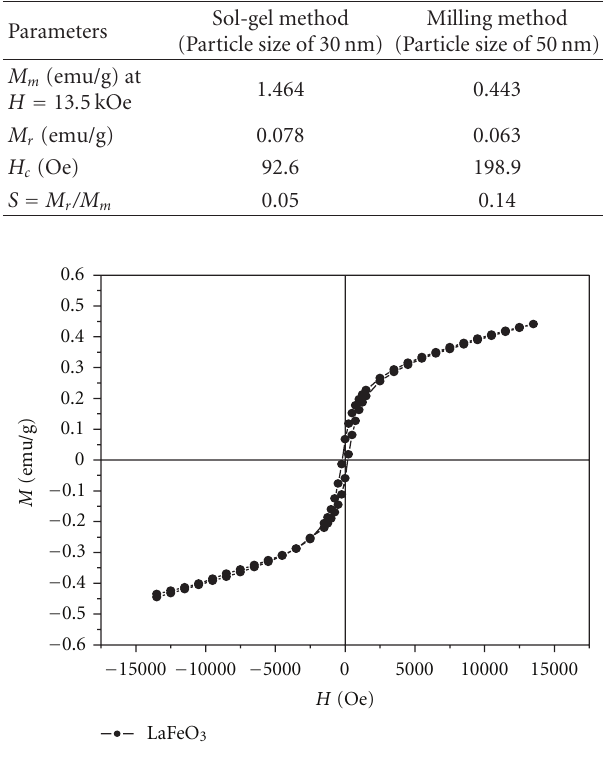
Figure 11: The M ( H ) curve at room temperature of nano-LaFeO 3 prepared by high-energy milling method.